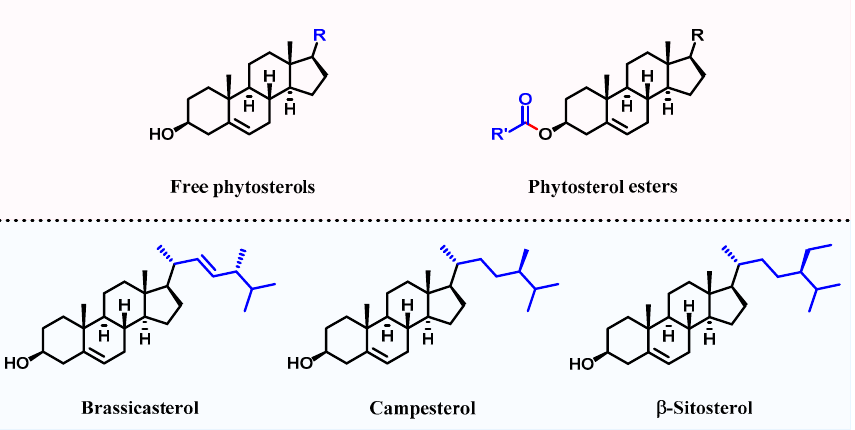
Figure 1. The chemical structures of free phytosterols, phytosterol esters, brassicasterol, campesterol and β -sitosterol.